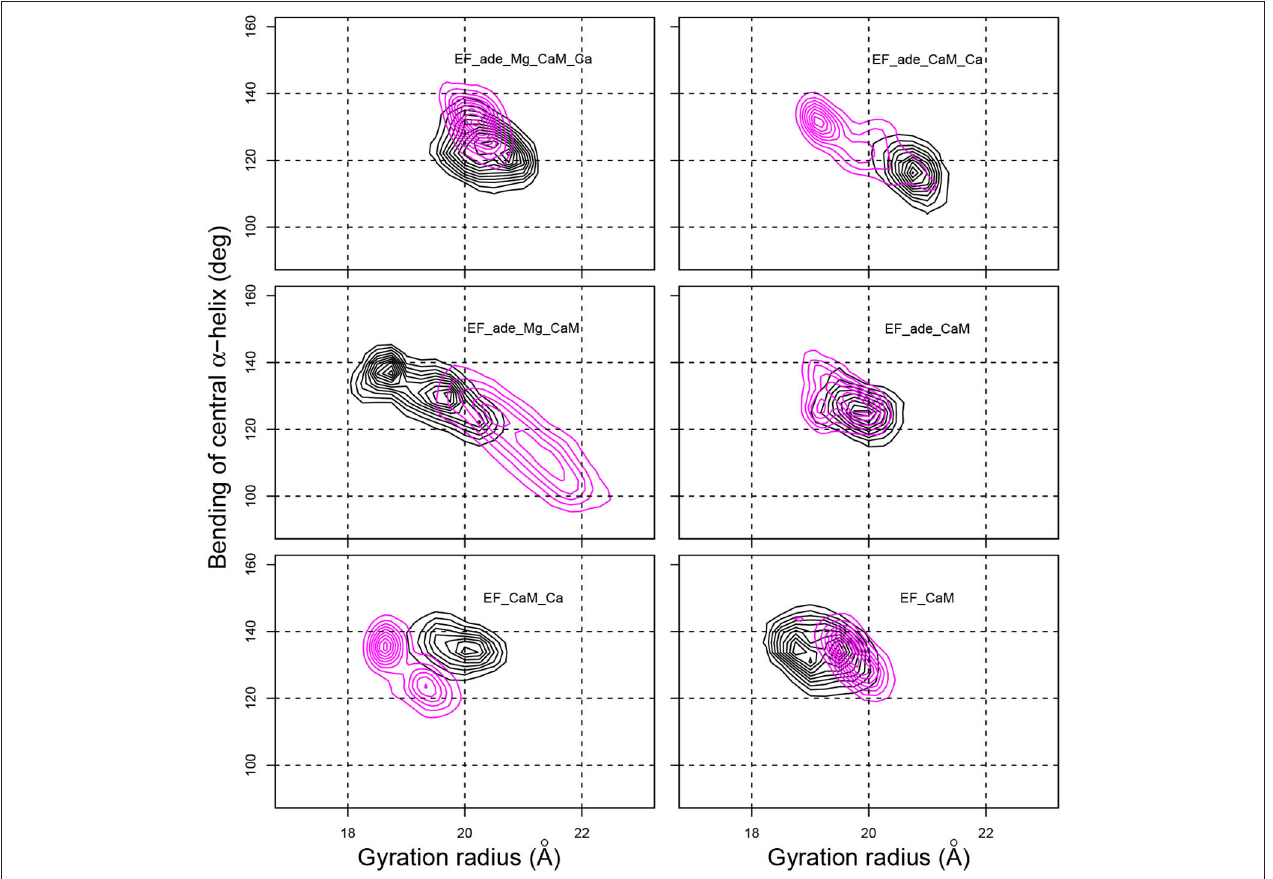
FIGURE 4 | Contour plots describing the variation of the gyration radius (Å) with respect to the bending angle of the CaM central α -helix (deg) determined as the angles between axes of α helices IV (residues 66-73) and V (residues 83-92). The contour lines describe the joint probability distribution of these two parameters. For each trajectory, the black and magenta contours correspond to replicas R1 and